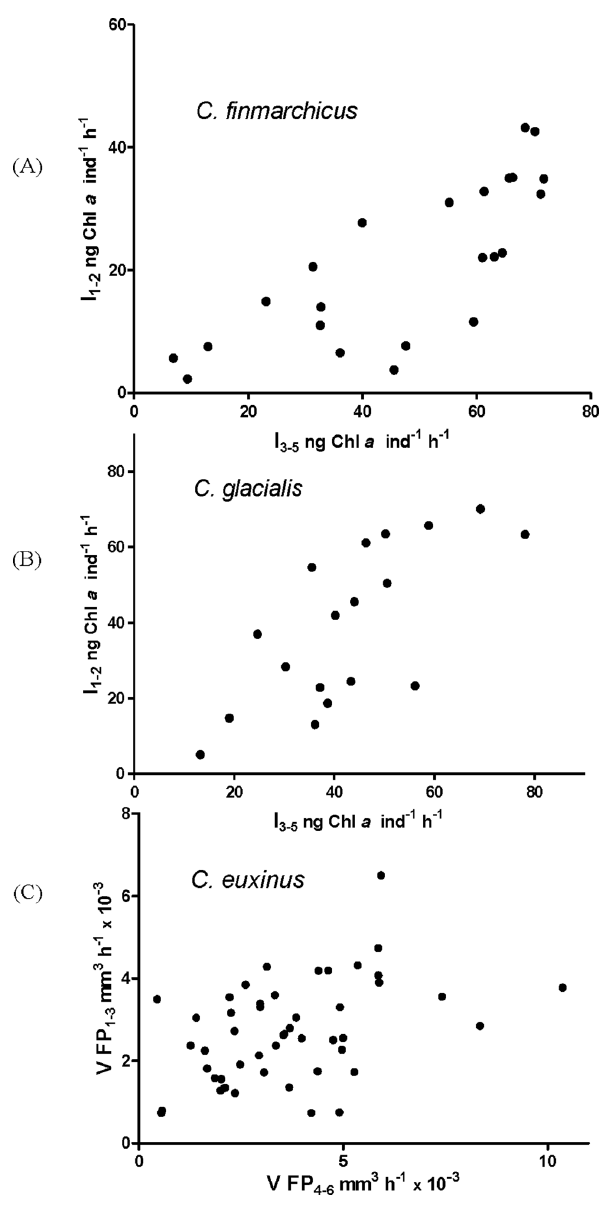
Figure 2. Separating the ‘true’ physiological structuring in the population of grazers from possible effects of random variation in different experiments. For each specimen the ingestion rate averaged over the first part of experiments is plotted against the ingestion rate averaged over the second part of experiment. The estimated correlation coefficients are shown in each graph. In all cases positive correlation (determined by taking Spearman correlation coefficients) between the two parts of experiment was found to be statistically significant, the correlation coefficients being, respectively, R =0.82; R =0.72; R =0.54 ( P , 0.0001).